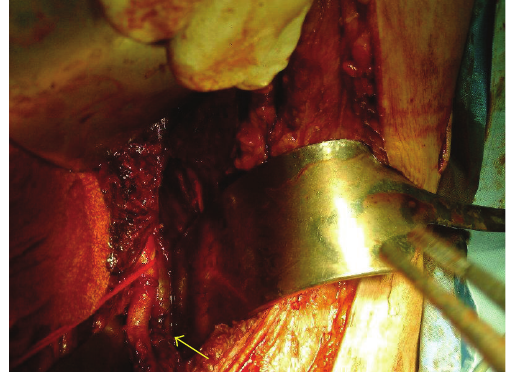
Figure 3: Sutured wall of the iliac vein